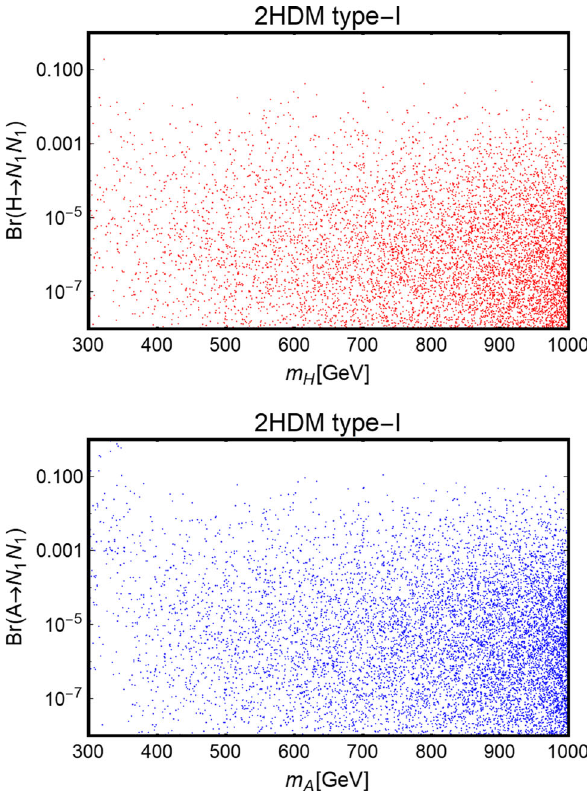
Fig. 13 Decay branching ratios of the heavy CP-even ( top panel ) and CP-odd ( bottom panel ) scalar into N 1 N 1 , as function of their